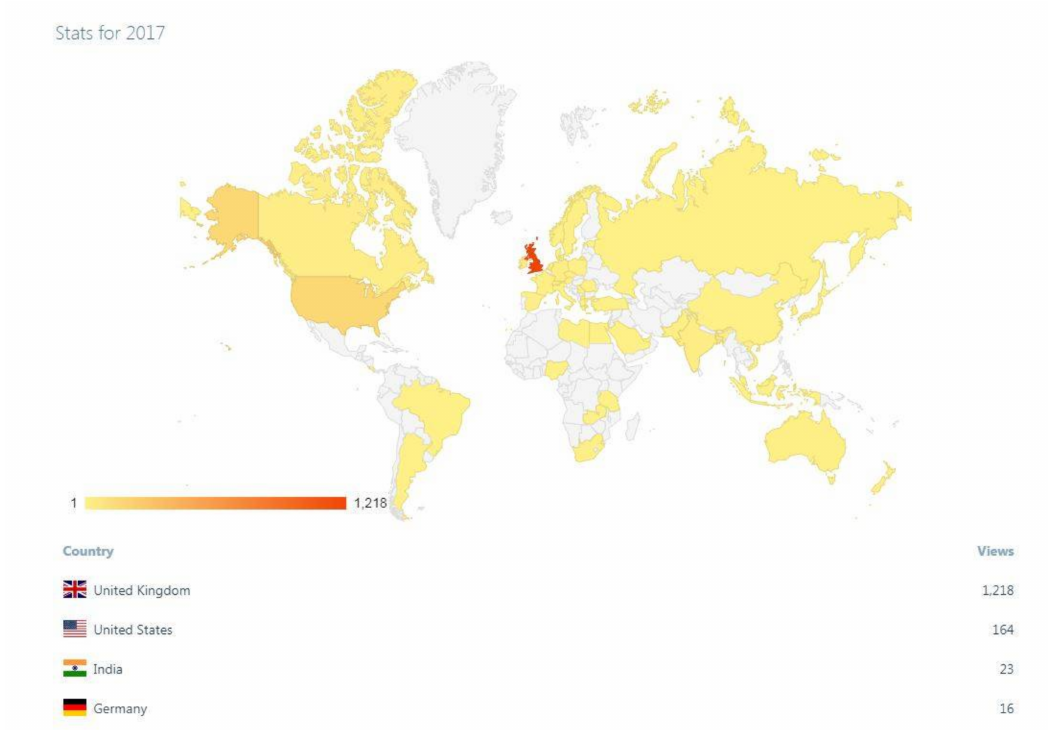
Figure 1. Blog views by geographical location 2017.